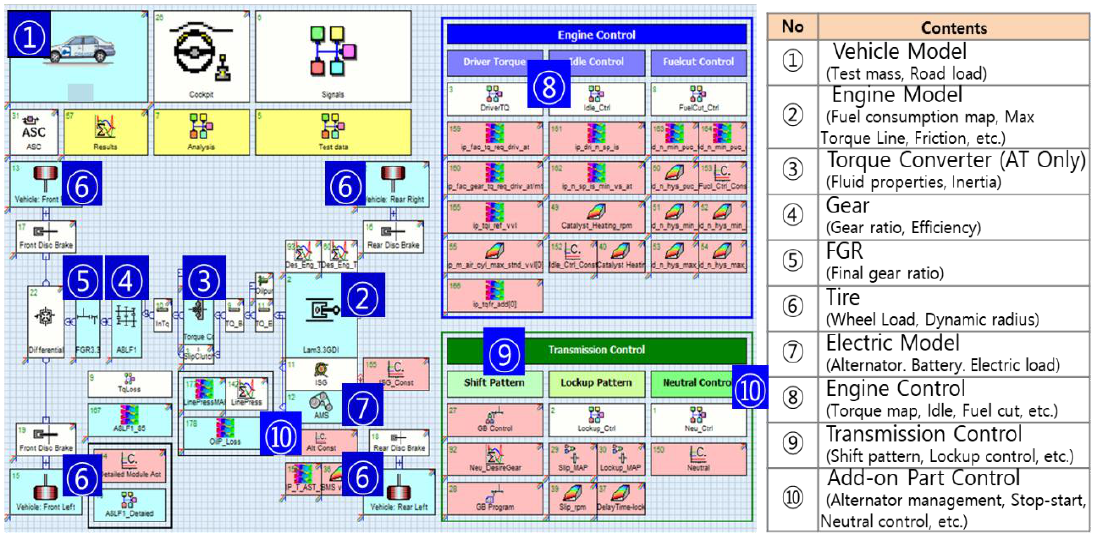
Figure 1. Vehicle simulation model by AVL CRUISE TM .